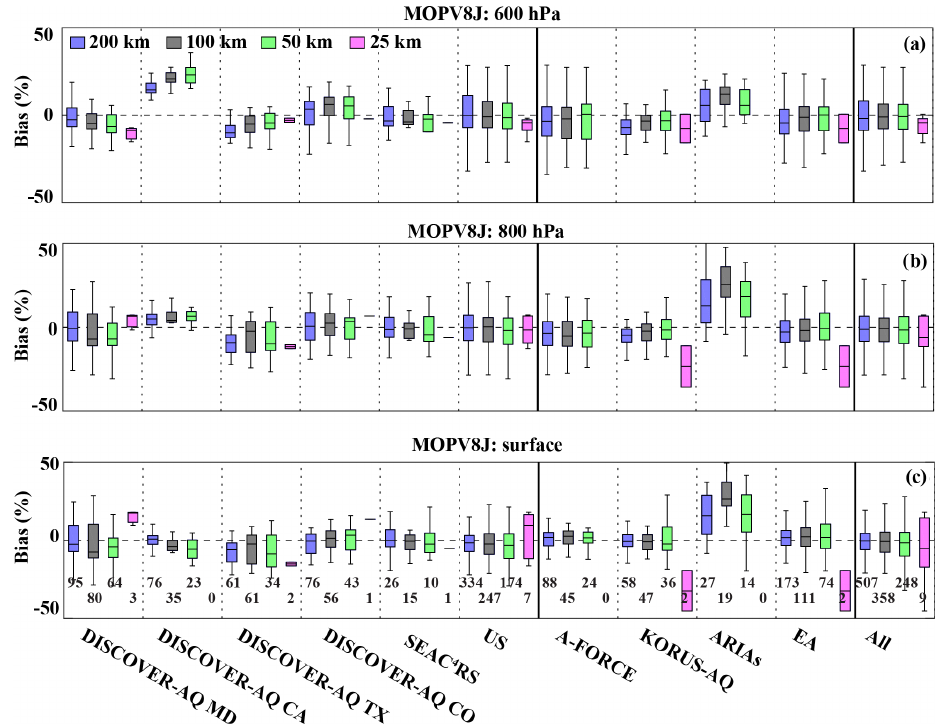
Figure 9. Sensitivity to the radius as criteria for co-location. Biases (%) using 200km (blue), 100km (gray), 50km (green), and 25km (pink) as the radius for co-location at 600hPa layer (a) , 800hPa layer (b) , and the surface layer (c) are shown by box plot (with medians represented by middle bars, interquartile ranges between 25th and 75th percentiles represented by boxes, and the most extreme data points not considered outliers represented by whiskers). The numbers in (c) correspond to the number of in situ profiles qualified for validation within the given radius. The biases are calculated against all (both urban and non-urban) in situ profiles listed in Table 1. The “100km” values (gray bars) are the same as yellow bars (for all data) in Fig. 6. See the caption of Fig. 6 for the definition of